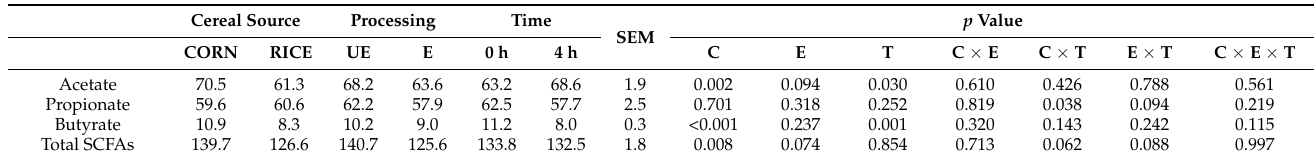
Table 7. Effects of cereal types and extrusion processing on the plasma concentrations ( µ mol/L) of SCFA of weaned piglets 1